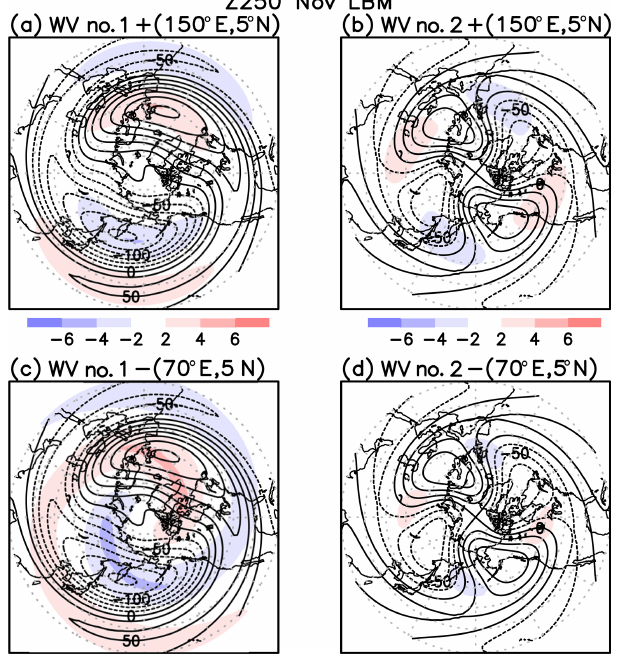
Figure 13. (a) AGCM simulated response of geopotential height at 250hPa (Z250) in November to the diabatic heating centered at 5 ◦ N, 150 ◦ E, against the control experiment. CI is 20m. The values statistically significant at 90% and 95% level are hatched. (b) Same as panel (a) but for the response of the zonal-mean zonal wind (CI of 0.5ms − 1 ). (c) Same as panel (a) but for a pair of diabatic heat- ing centered at 5 ◦ N, 150 ◦ E, and cooling centered at 5 ◦ N, 70 ◦ E. (d) Same as panel (b) but for the pair of the heating and cooling. In all figures, negative values are